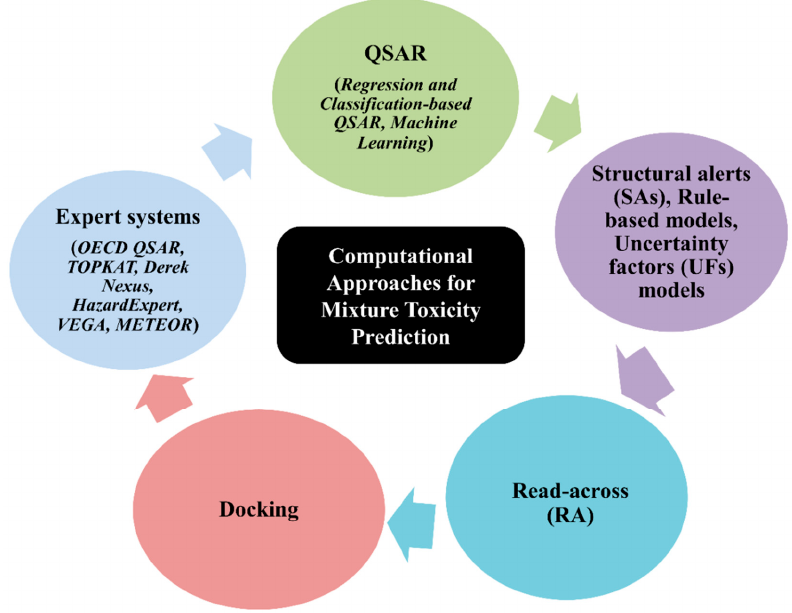
Figure 3. Types of computational approaches for the prediction of toxicity.